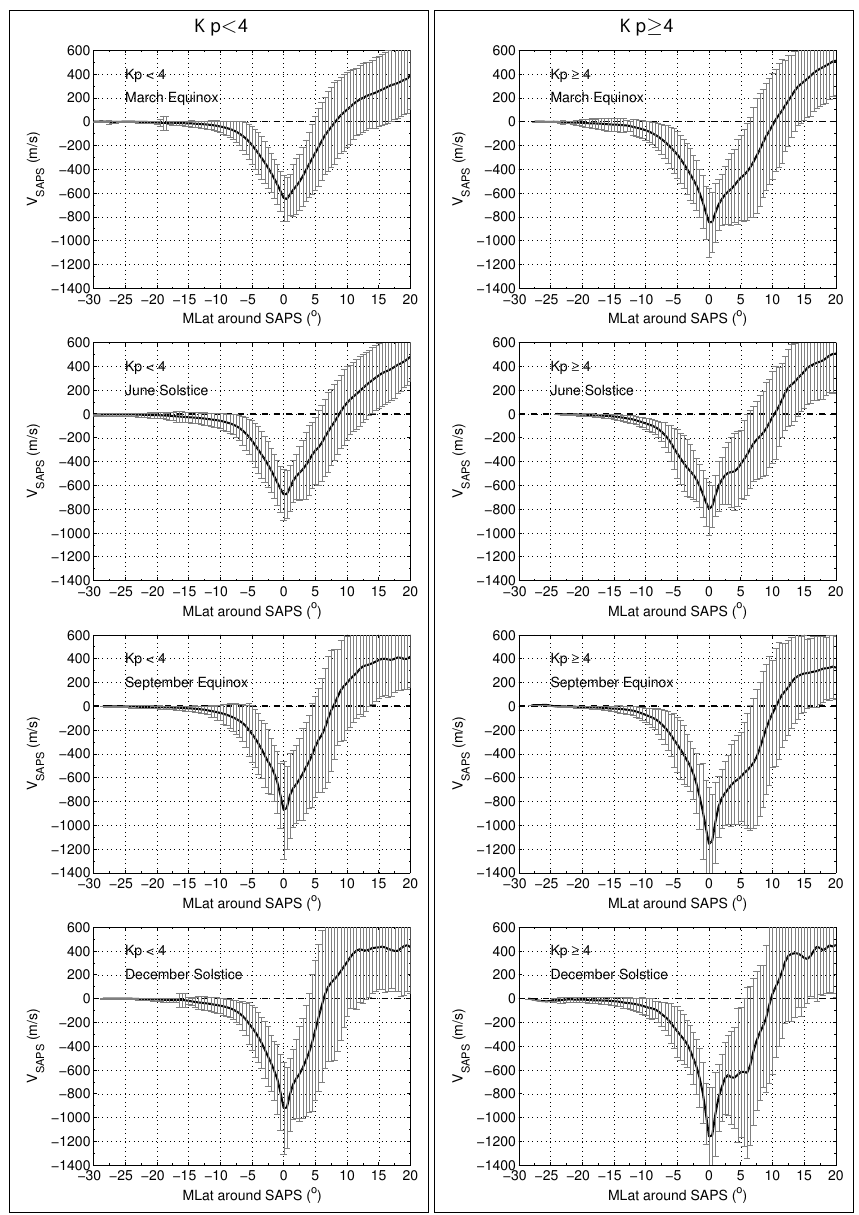
Fig. 2. Superposed epoch analysis of the cross-track velocity observed by DMSP F13 for different seasons and Kp levels. From top to bottom results are shown for local seasons of spring, summer, autumn and winter. The key MLat of “0” denotes the latitude where the SAPS velocity peak occurs. Positive values denote eastward velocity. The bars show the standard deviations of 0 . 5 ◦ averages.